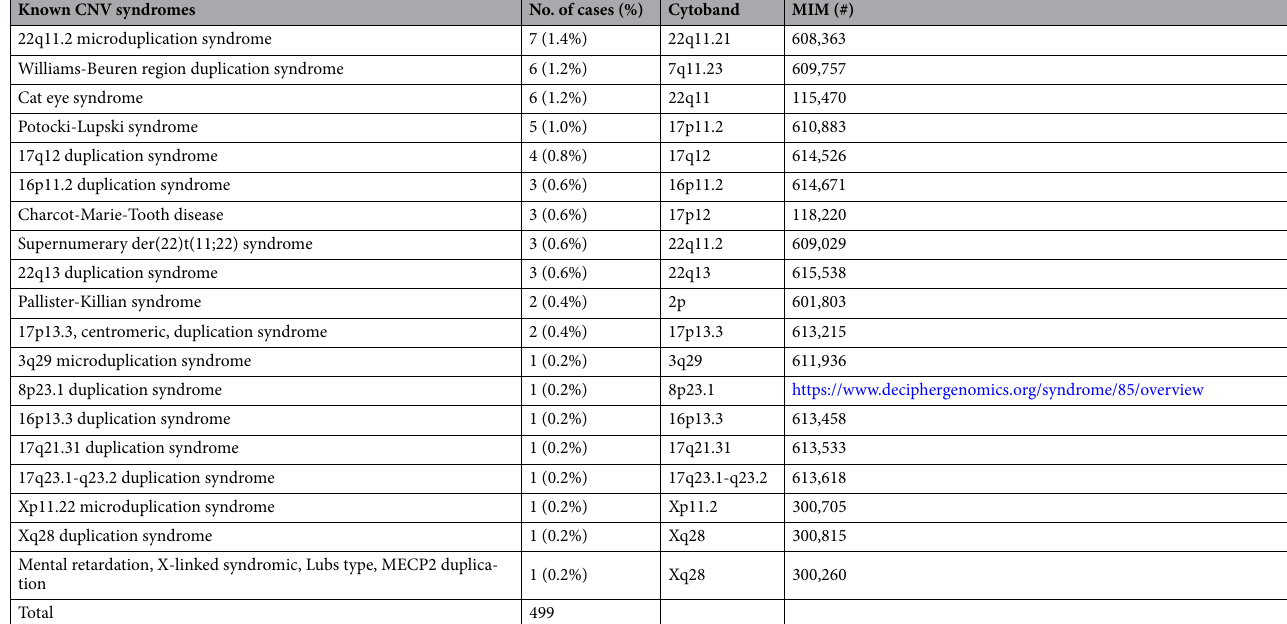
Table 1. Frequency of the known copy number variation (CNV)